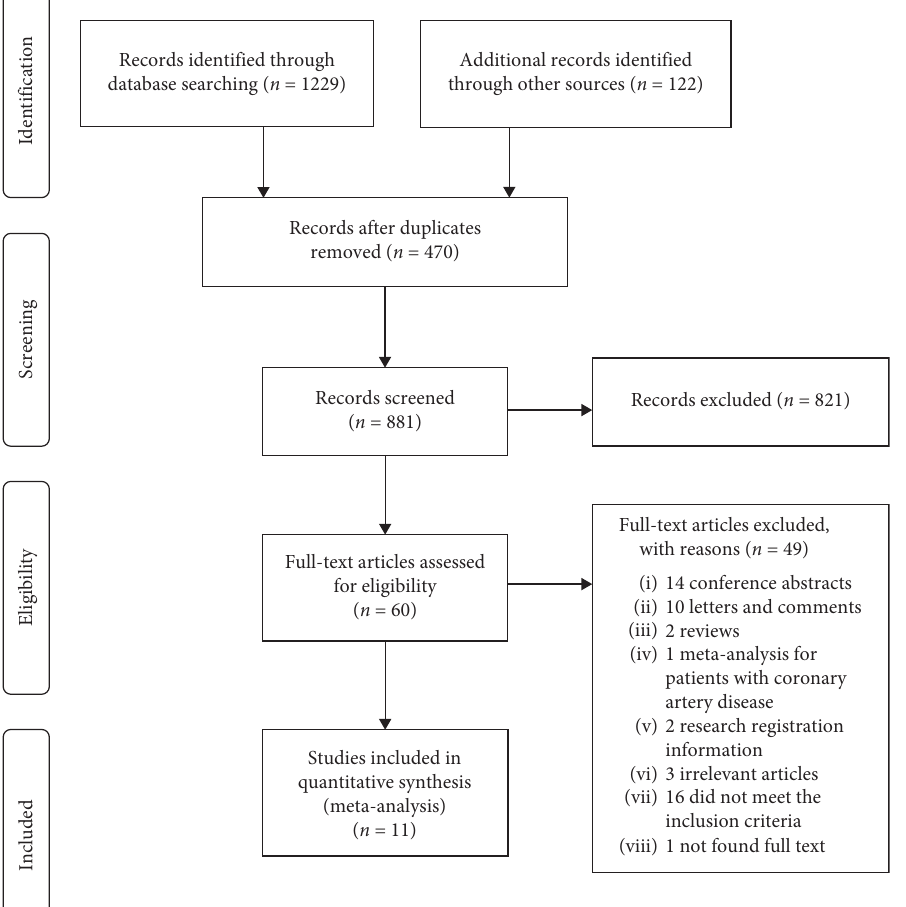
Figure 1: Flow chart of study